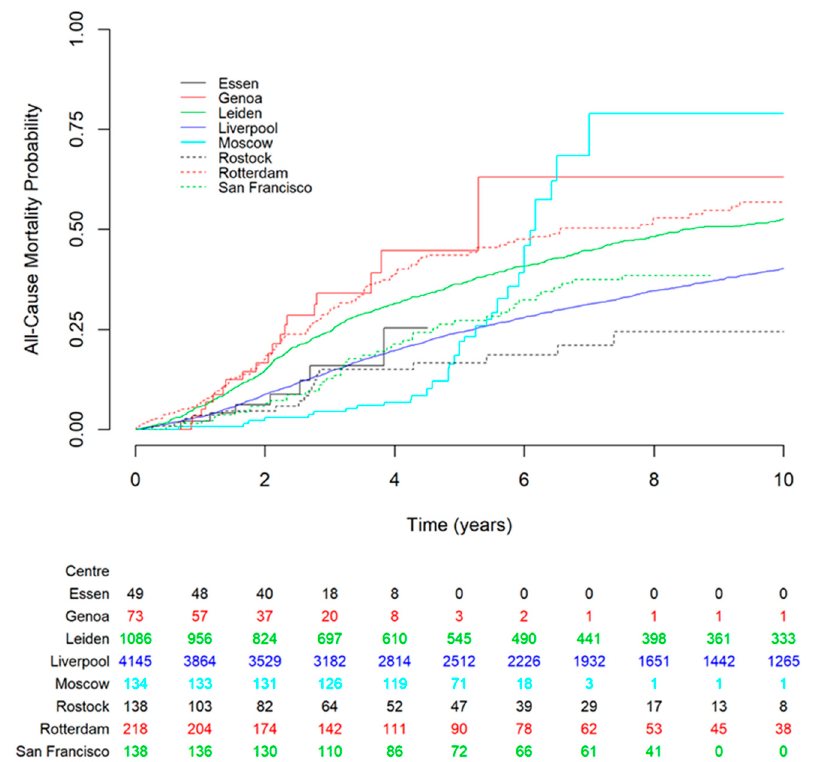
Figure 1. Kaplan–Meier estimates of all-cause mortality for the centers involved in the study. The Liverpool development dataset is shown in solid blue line for comparison. The figure shows that datasets from Essen and San Francisco had the closest match to the Liverpool dataset. The numbers below the figure are the number of subjects at risk entering the corresponding time point for each dataset.